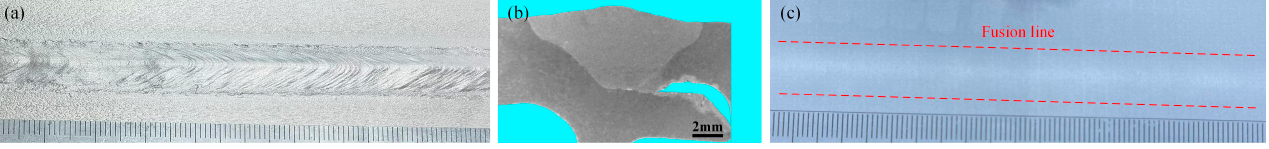
Figure 4. Weld quality of the optimized welding parameters: ( a ) surface; ( b ) cross-section; and ( c ) porosity.